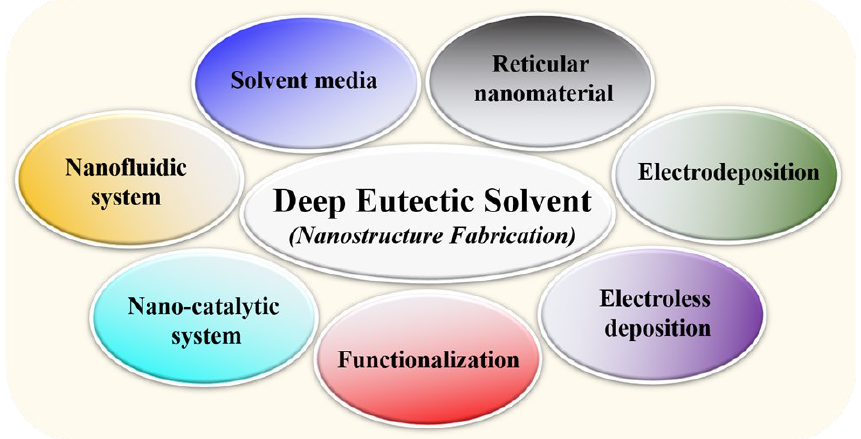
Figure 1. The applications of deep eutectic solvents (DESs) for nanomaterial fabrications.